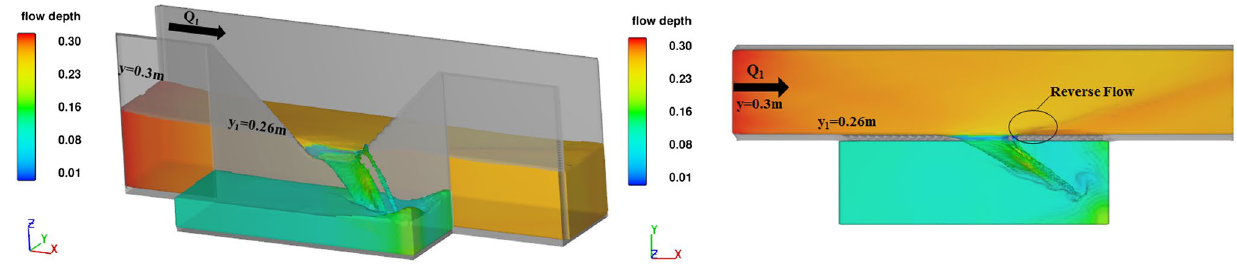
Fig. 4 Flow passing over a TSCSW with P = 20 cm